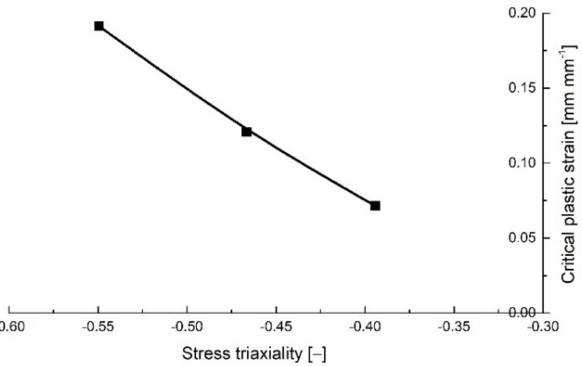
Figure 13. Critical plastic strain variation with stress triaxiality for the notched cylindrical specimens.